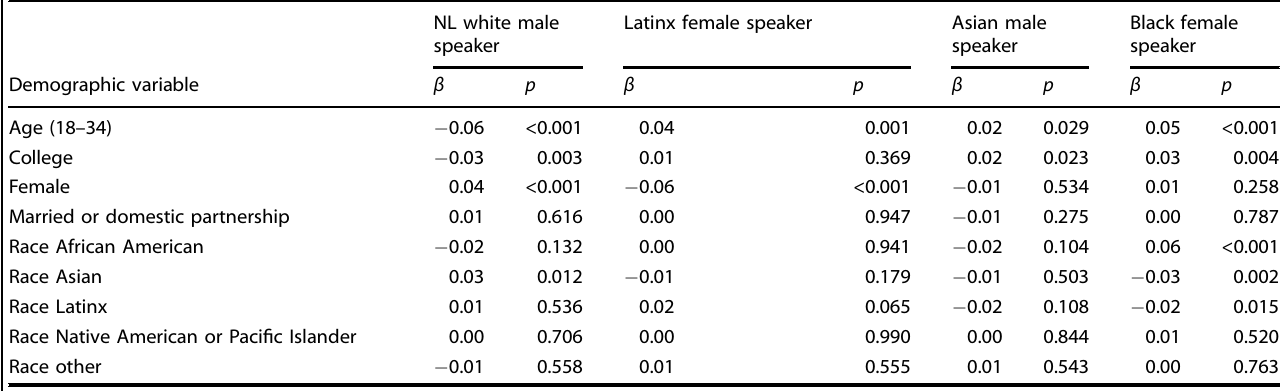
Table 5. Associations between meditation speaker proportions and